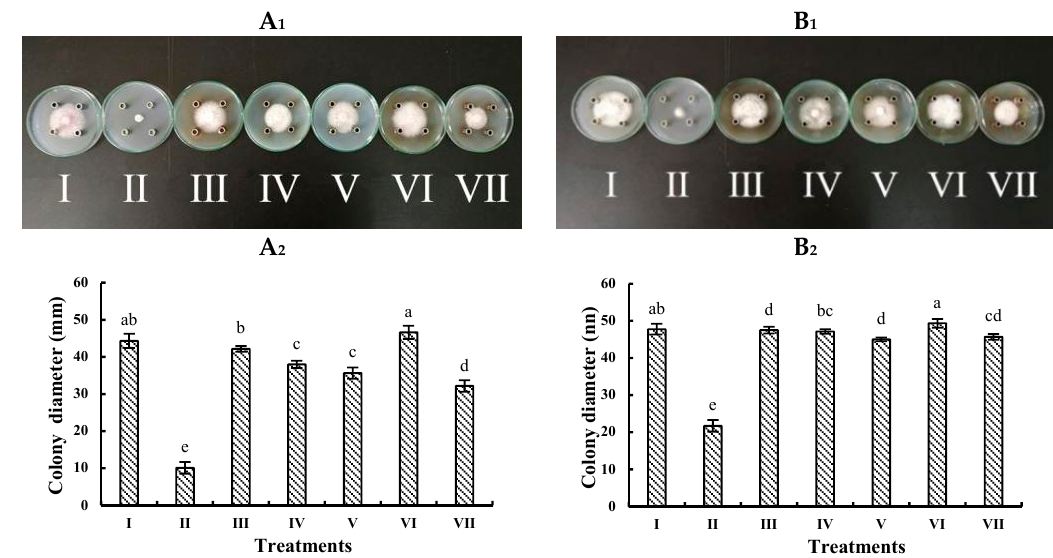
Table 1. Chemical composition and content of EO from A. annua.